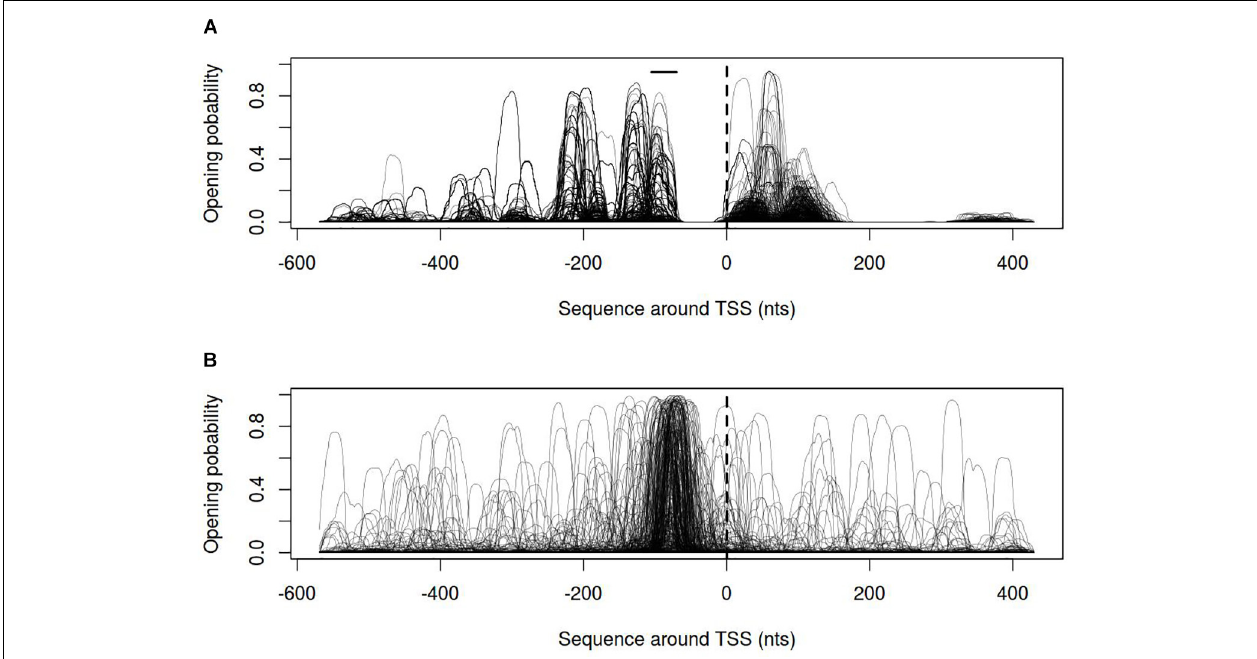
FIGURE 6 | Opening probability (SIDD) profiles for (A) vlhA promoters of 12 M. gallisepticum strains; (B) sigma 70 promoters of S6 strain. Dashed line denotes transcription start site; solid horizontal line – approximate GAA repeats location.